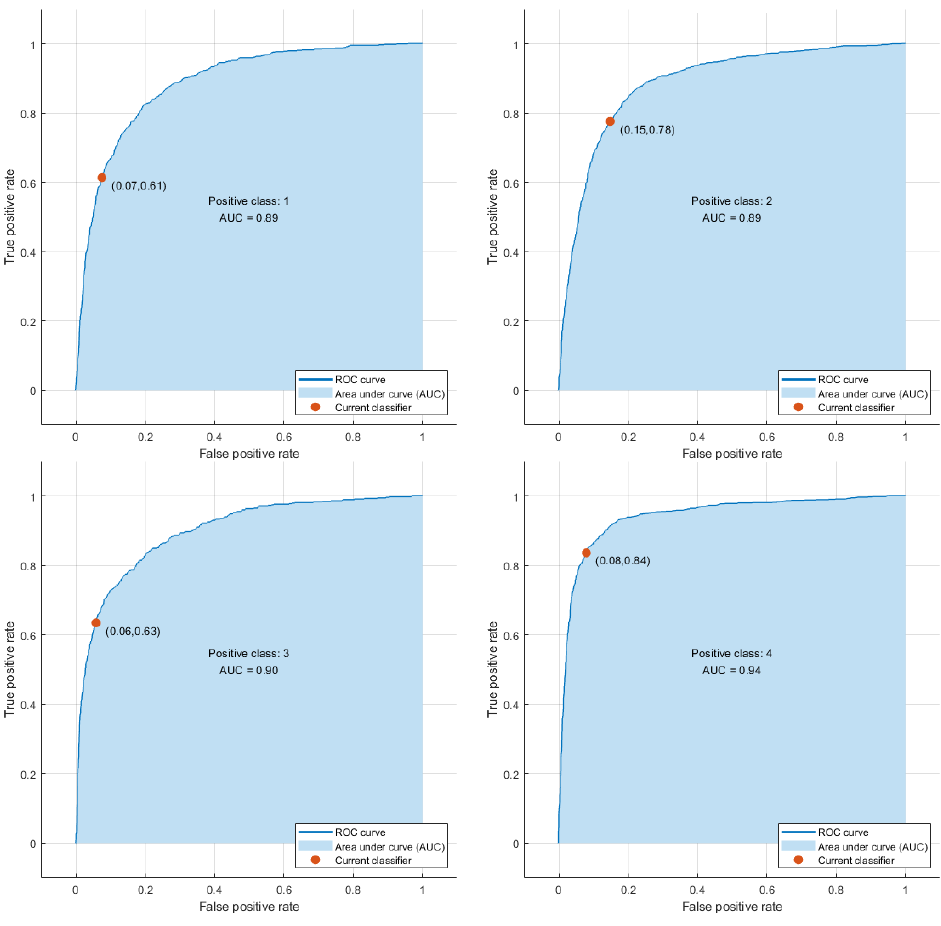
Figure A1. Confusion matrix of the SVM classifier.